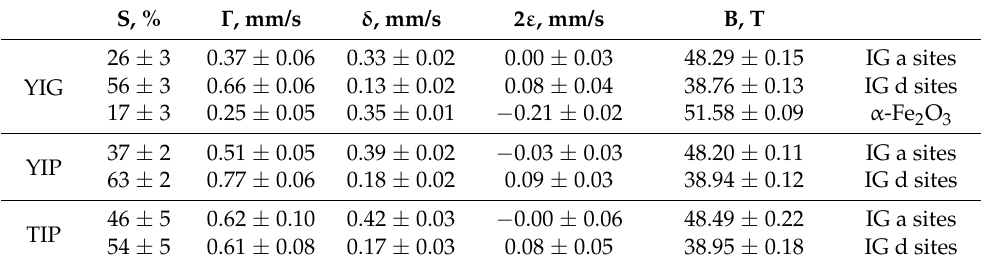
Figure 9. Conversion electron Mössbauer spectra of ( a ) YIG, ( b ) YIP, and ( c ) TIP layers. Table 4. Data from conversion electron Mössbauer spectra measured at room temperature for YIG, YFO and TFO layers on Si: S is relative area of subspectrum, Γ , δ , 2 ε , and B are line width, isomer shift, quadrupole shift, and hyperfine field,